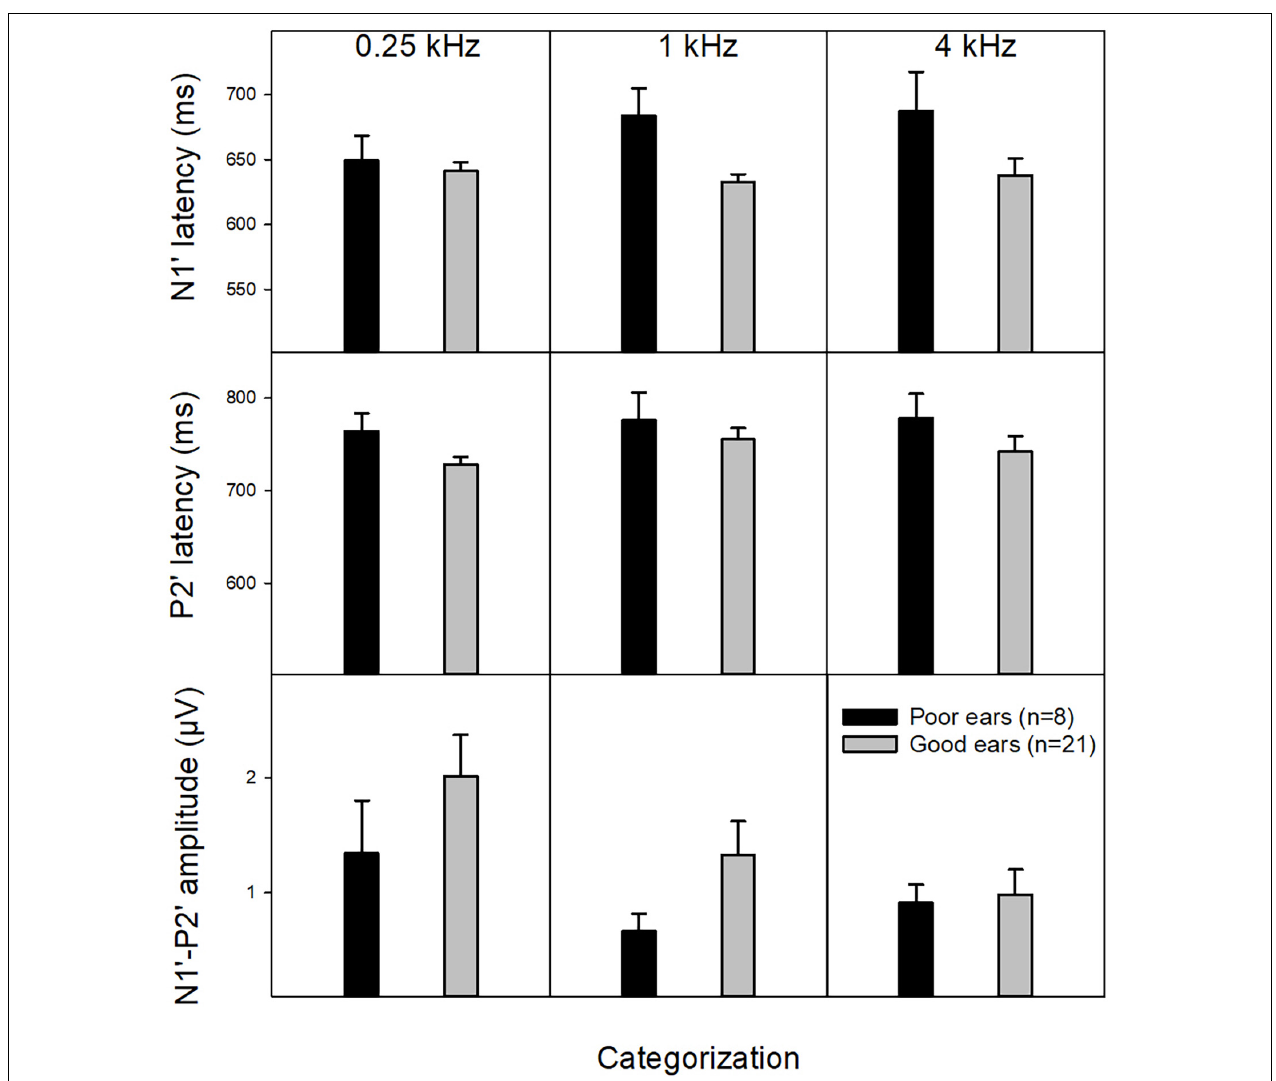
FIGURE 4 | The mean ACC measures (N1 (cid:48) and P2 (cid:48) latencies as well as the N1 (cid:48) -P2 (cid:48) amplitude) in good and poor CI ears at the three f bases . Mann–Whitney Rank Sum Test showed that the difference in ACC measures between these two subgroups did not reach statistical significance ( p >